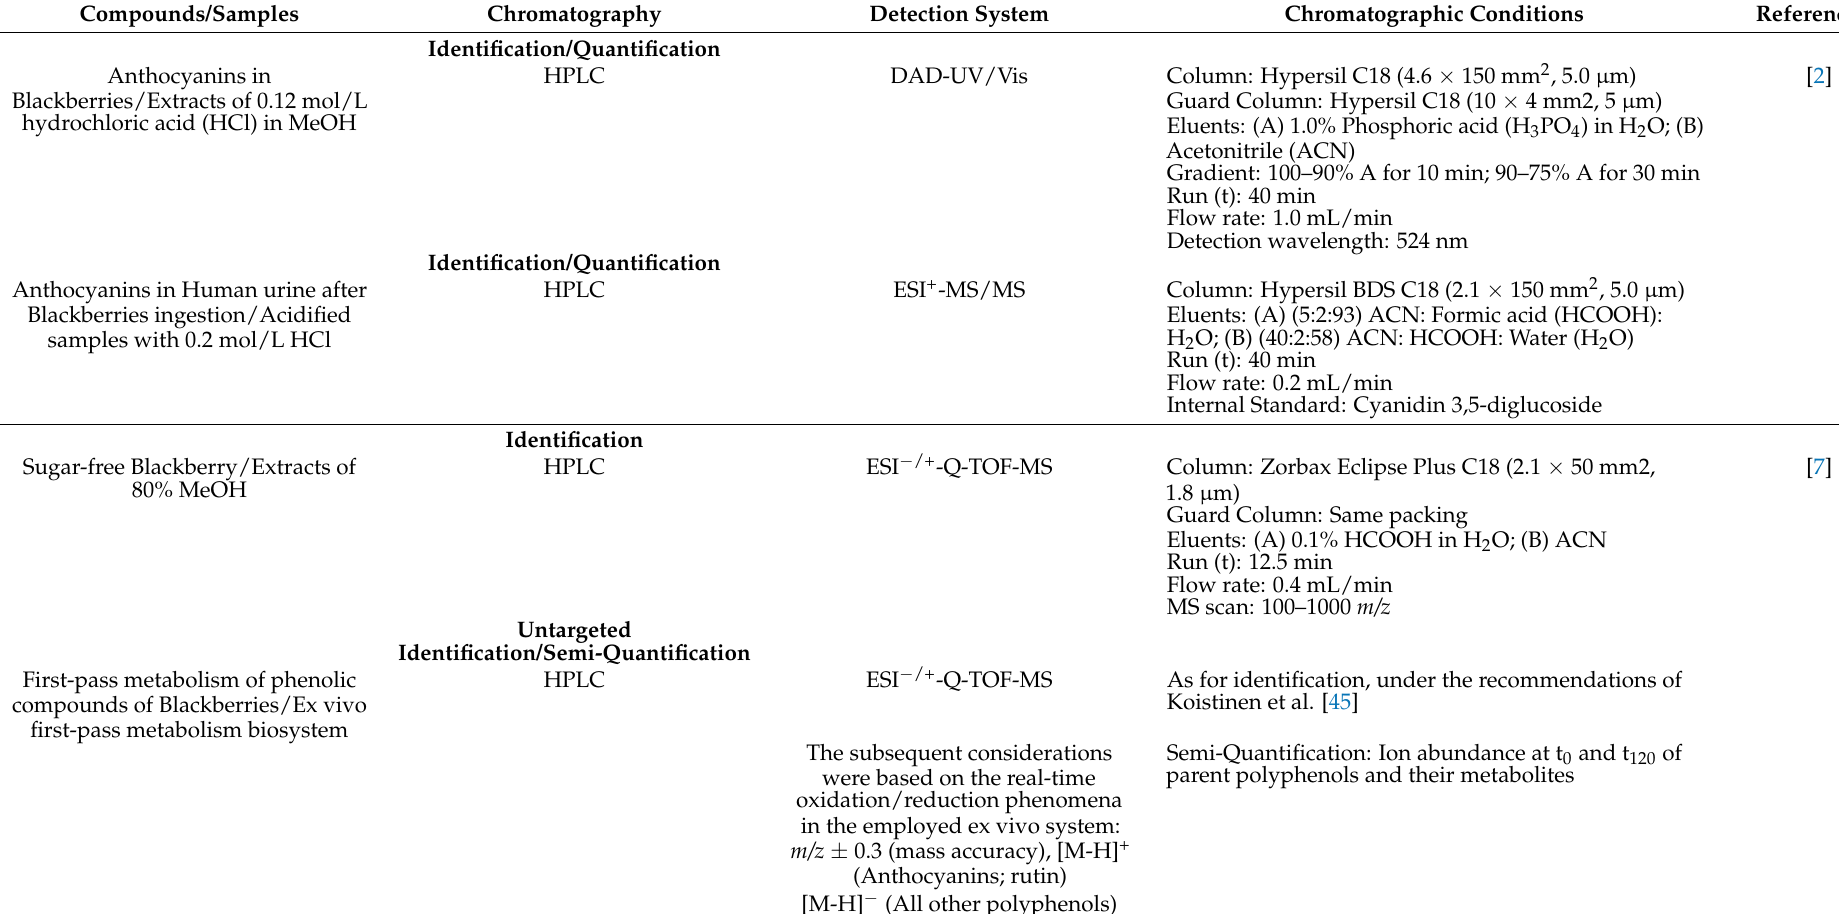
Table 1. Identification and quantification analytical techniques of anthocyanins and their metabolites in blackberries and